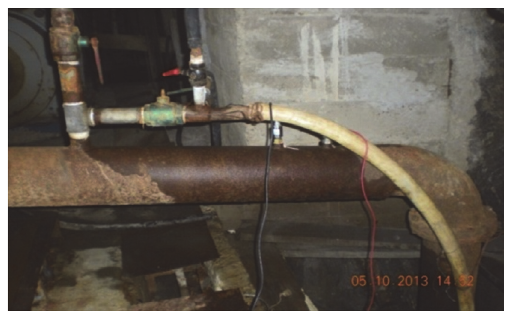
Figure 8: Sensors installation instruction in water inlet.